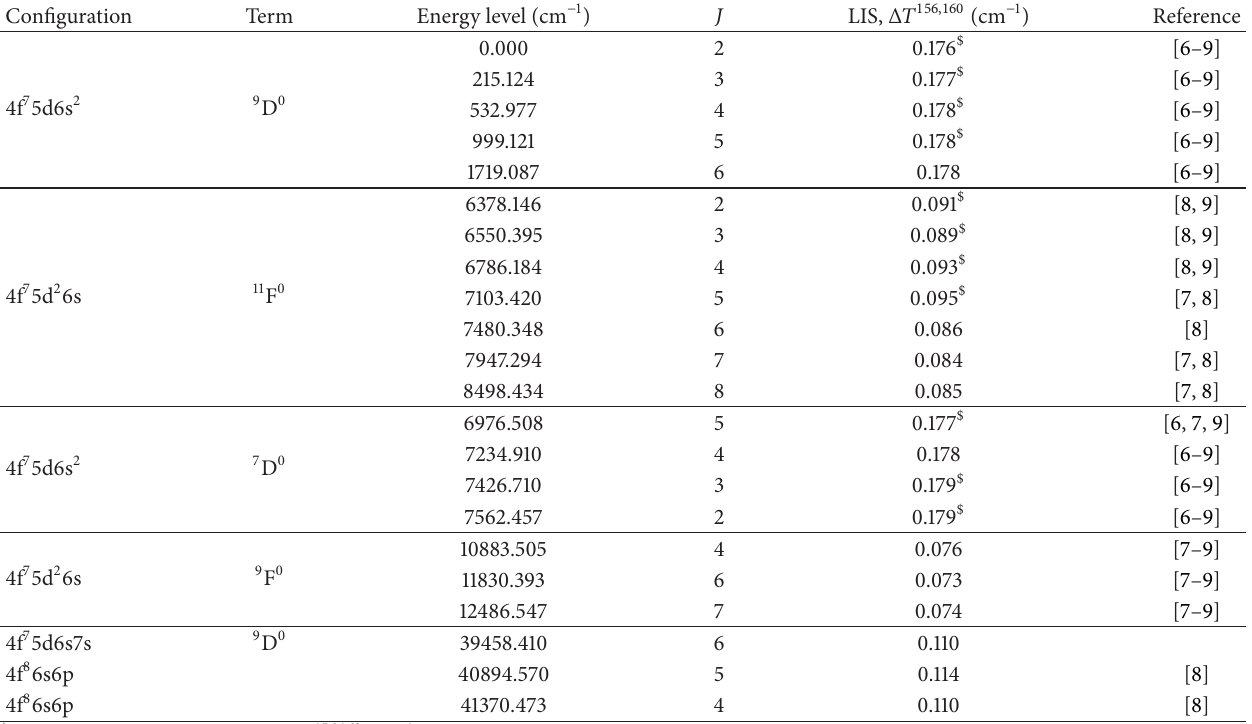
Table 3: Odd-parity energy levels (cm −1 ), their configurations, term, and 𝐽 values have been taken from [1]. LIS Δ𝑇 156,160 (cm −1 ) have been referred from